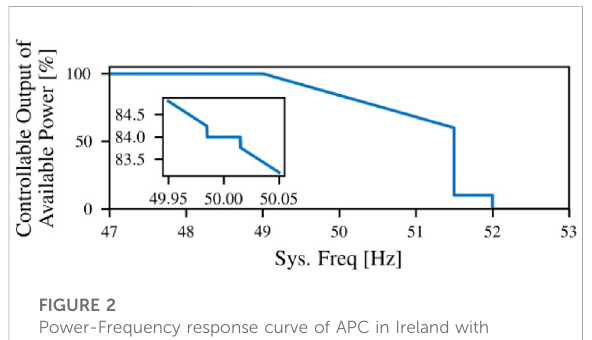
FIGURE 2 Power-Frequency response curve of APC in Ireland with 15 mHz deadband.